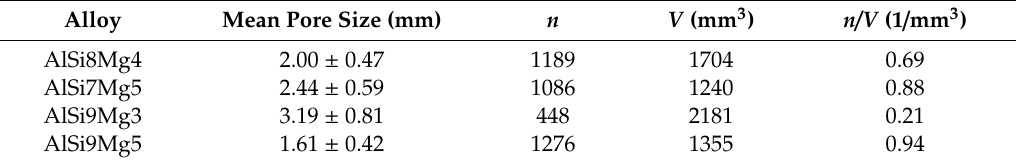
Table 2. Characteristic values of the foam structure obtained from tomographic analyses.